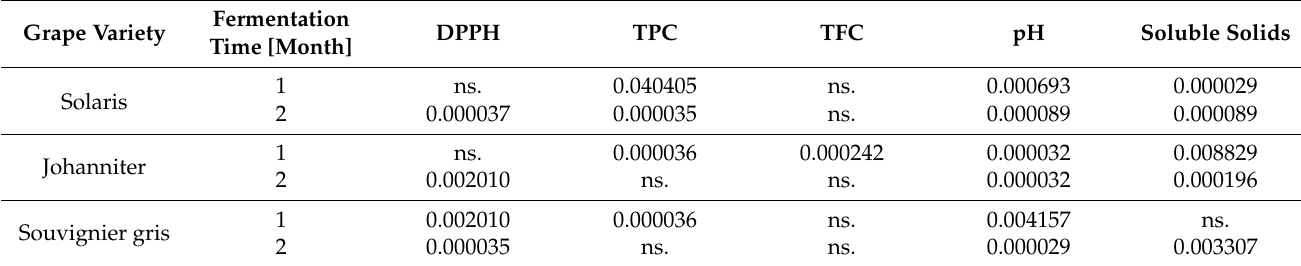
Table 2. The p -values of the Kruskal–Wallis test for samples made with sugar (variant B) vs. without added sugar (variant A) during fermentation